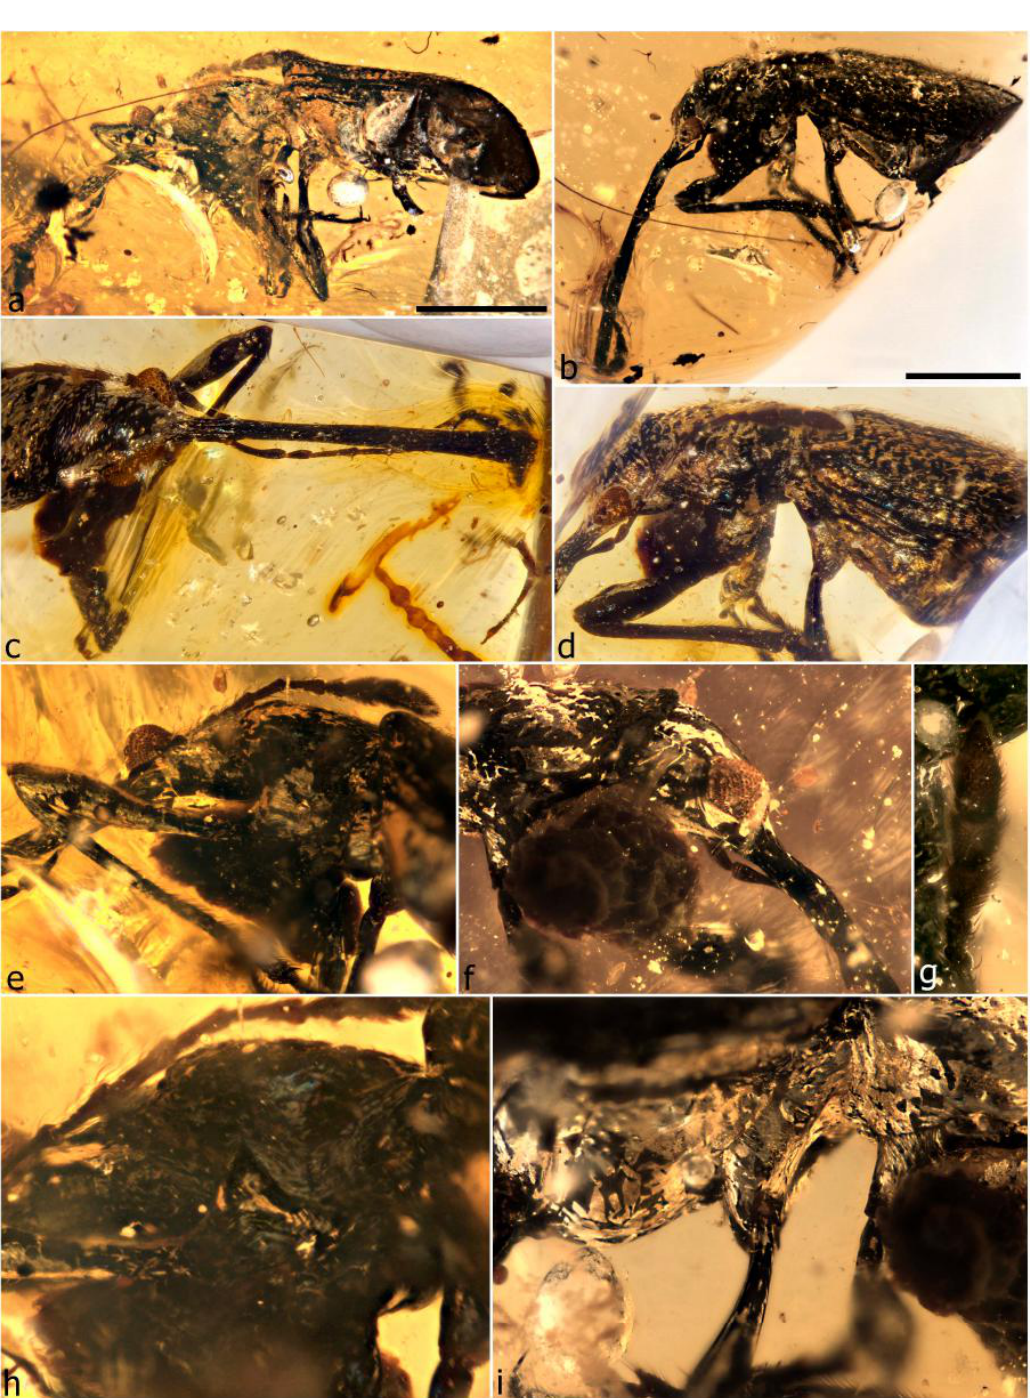
Figure 17. Rhynchitomimus chalybeus sp. n., holotype. Habitus, right lateral oblique ( a ); habitus, left lateral ( b ); head and antenna, dorsal ( c ); head, prothorax and pterothorax, left lateral ( d ); prothorax and antenna, left lateral oblique ( e ); head and prothorax ( f ); antennal club ( g ); prothorax showing widely open notosternal suture ( h ); meso- and metathorax and mesocoxa, right lateral ( i ). Scale bars: 1.0 mm (a,b).